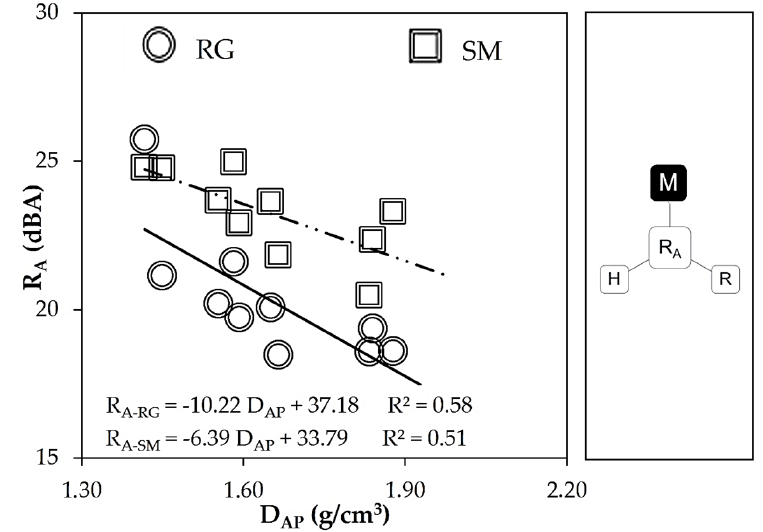
Figure 5. Quantification of the sound reduction index (R A ) plotted against the weight per unit volume (D AP ).